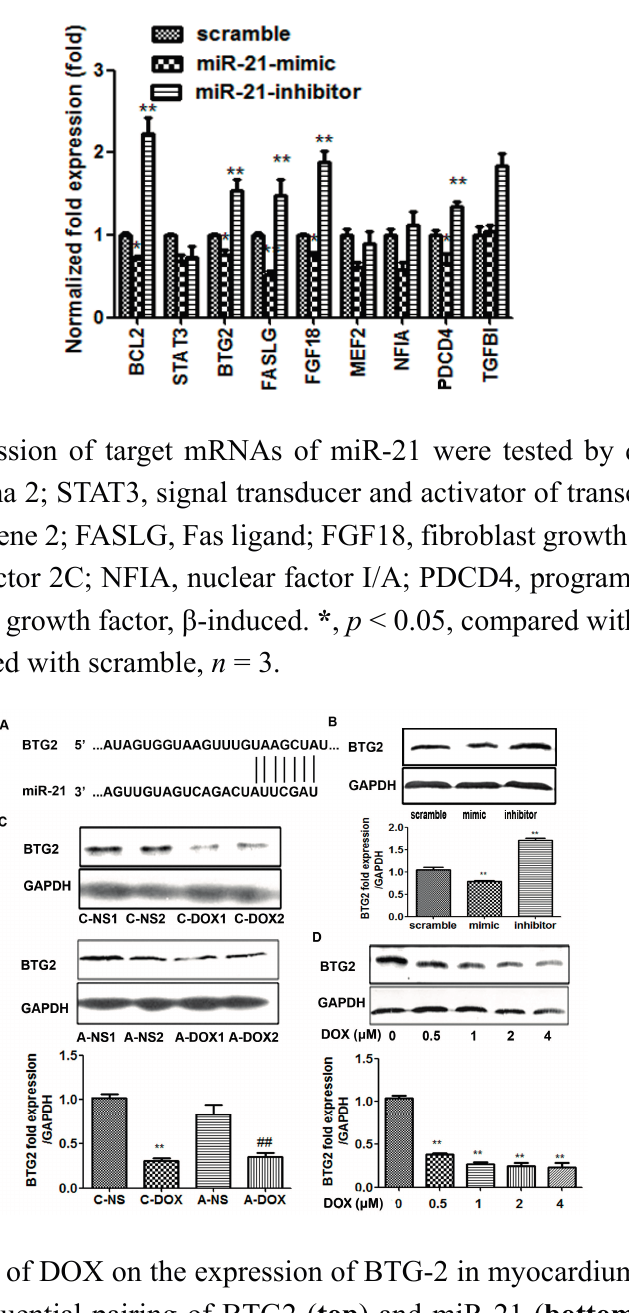
Figure 5. The effects of DOX on the expression of BTG-2 in myocardium and H9C2 cells. ( A ) Predicted consequential pairing of BTG2 ( top ) and miR-21 ( bottom ) by TargetScan; ( B ) The expression levels of BTG2 in H9C2 cells transfected with rno-miR-21 mimics/inhibitors/scrambled controls detected by western blotting. ** , p < 0.01, compared to that of cells transfected with scramble, n = 3; ( C ) The expression levels of BTG2 in A-DOX and C-DOX myocardium. A-NS1, A-NS2 represented two different samples. C-DOX: Chronic DOX injury group; C-NS: Chronic normal saline control group. A-DOX: Acute DOX injury group; A-NS: Acute normal saline control group. 1, 2 behind them represent two different samples. ** , p < 0.01, compared to that of C-NS group, n = 3; ## , p < 0.01, compared to that of A-NS group, n = 3; and ( D ) The expression levels of BTG2 in H9C2 cells treated with DOX (0–4 µm for 24 h). The panel above was the representative western blotting image and the panel below was quantitative analysis. ** , p < 0.01, compared to that at 0 µM DOX, n =